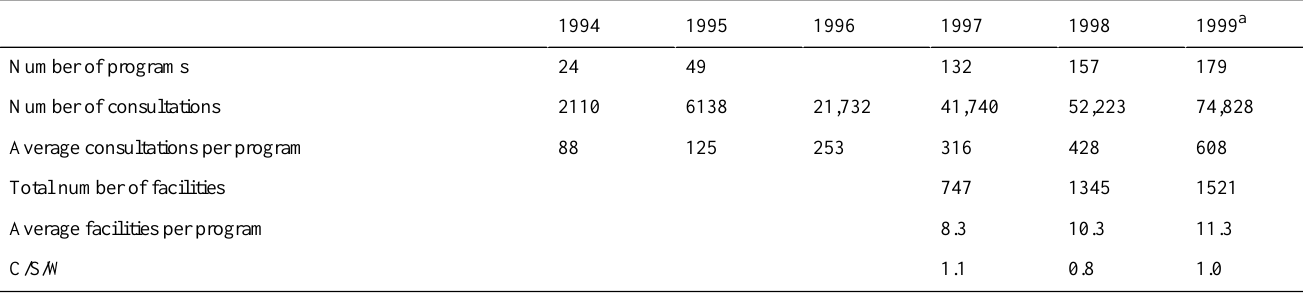
Table 1. Growth in North American telehealth activity, 1994-1999, excluding teleradiology services